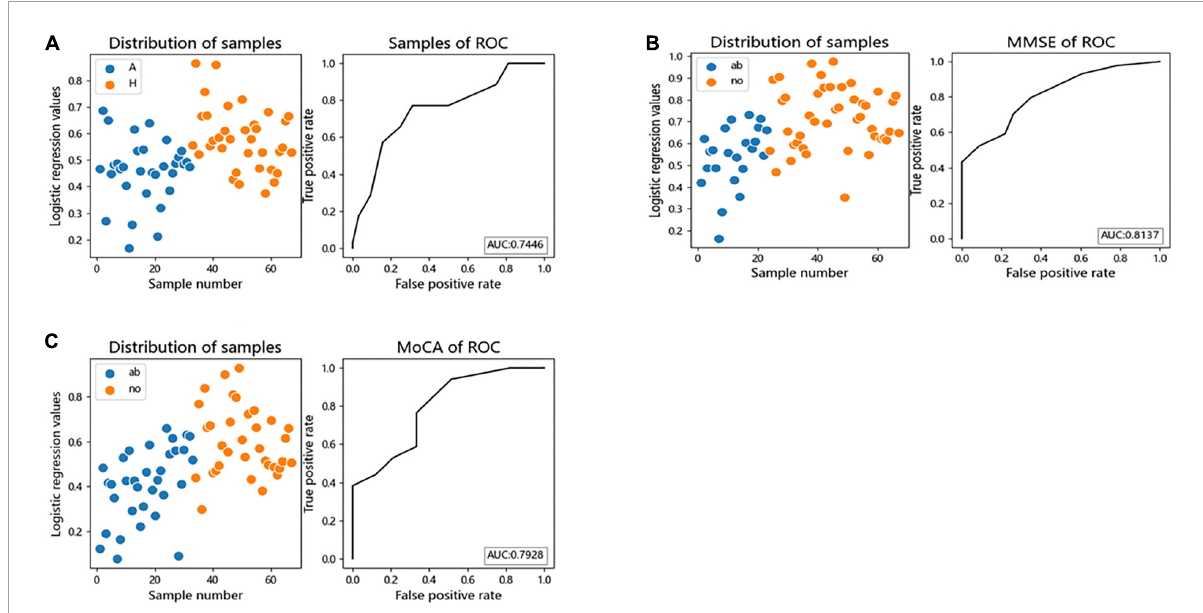
FIGURE5 The differential genera as AUD and cognitive function diagnostic markers. (A) Receiver operating characteristic (ROC) curves of subject genus-level samples used to differentiate AUD patients from HC; (B) ROC curves classified by the MMSE scores of subject were used to predict cognitive function; (C) ROC curves classified by the MoCA scores of subject were used to predict cognitive function. AUC, the area under the receiver operating characteristic curve; ab, abnormal cognitive function; no, normal cognitive